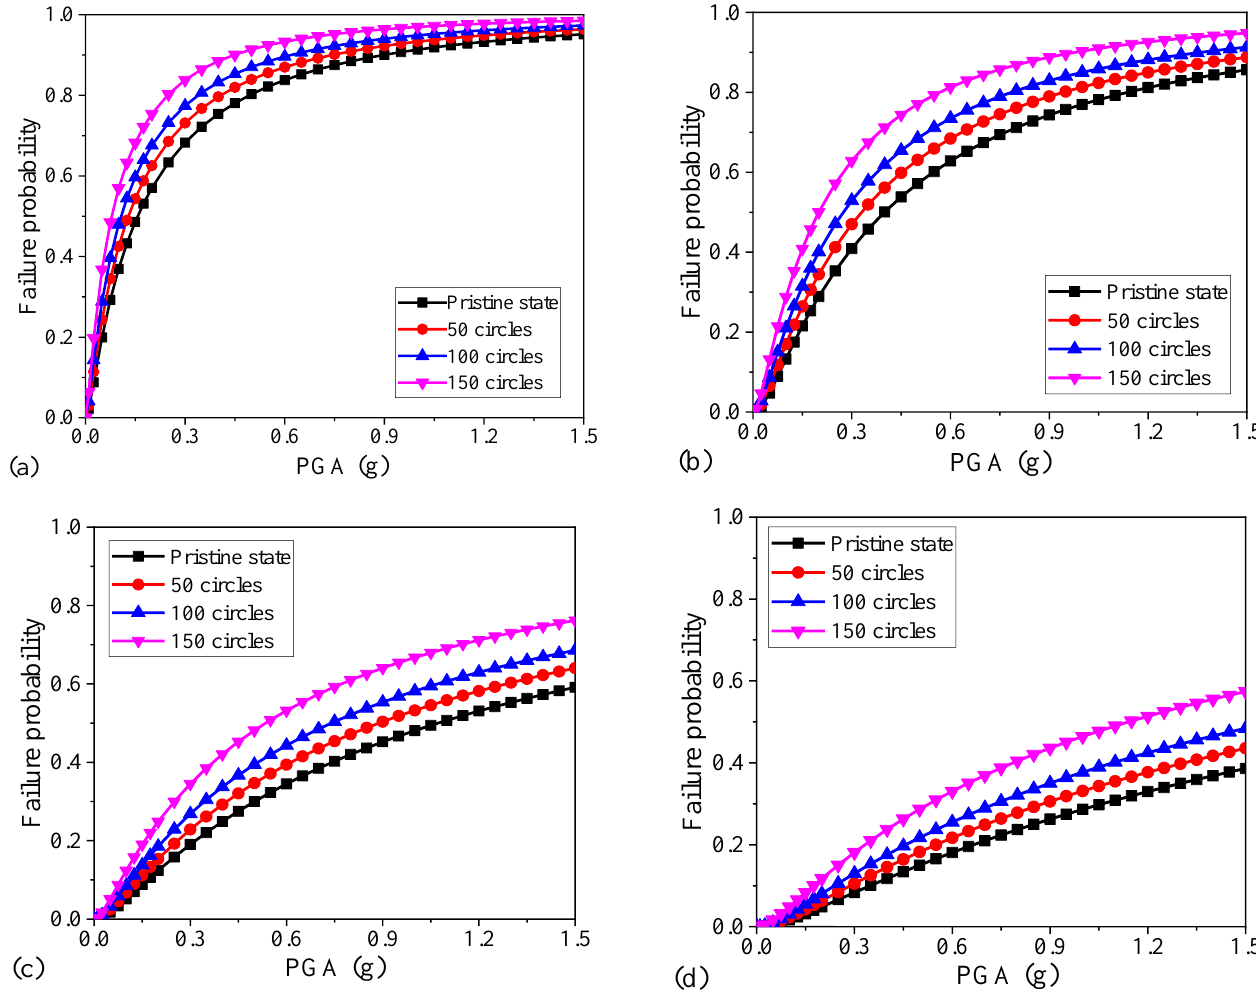
Figure 7. Fragility curves of the columns under different freeze – thaw cycles: ( a ) slight, ( b ) moderate, ( c ) extensive, and ( d ) complete damage states.